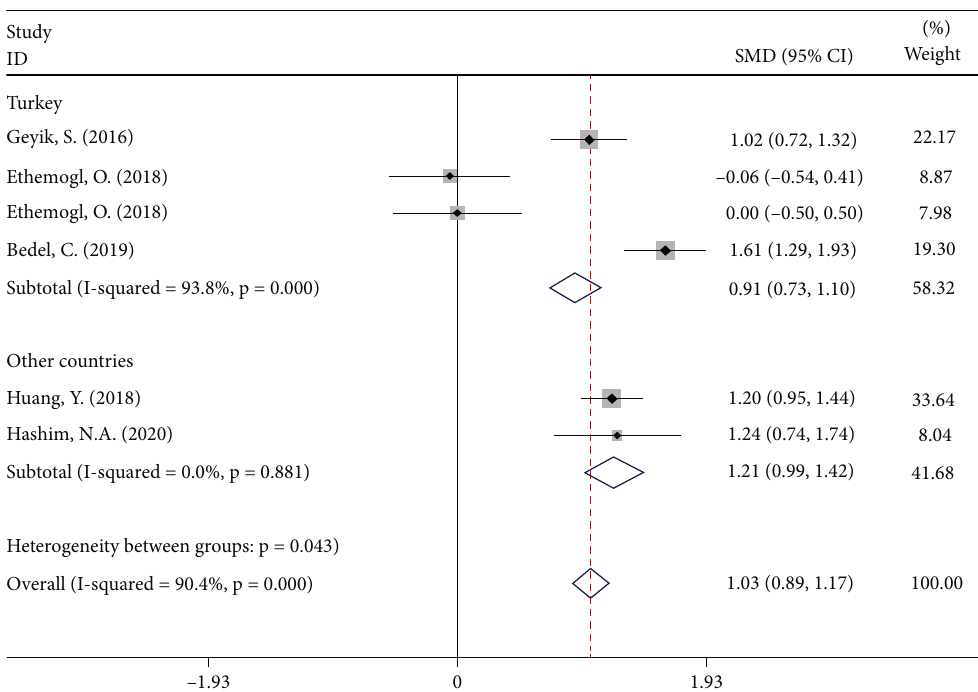
Figure 4: Subgroup analysis of di ff erences in NLR levels between GBS patients before treatment and healthy controls according to study location.